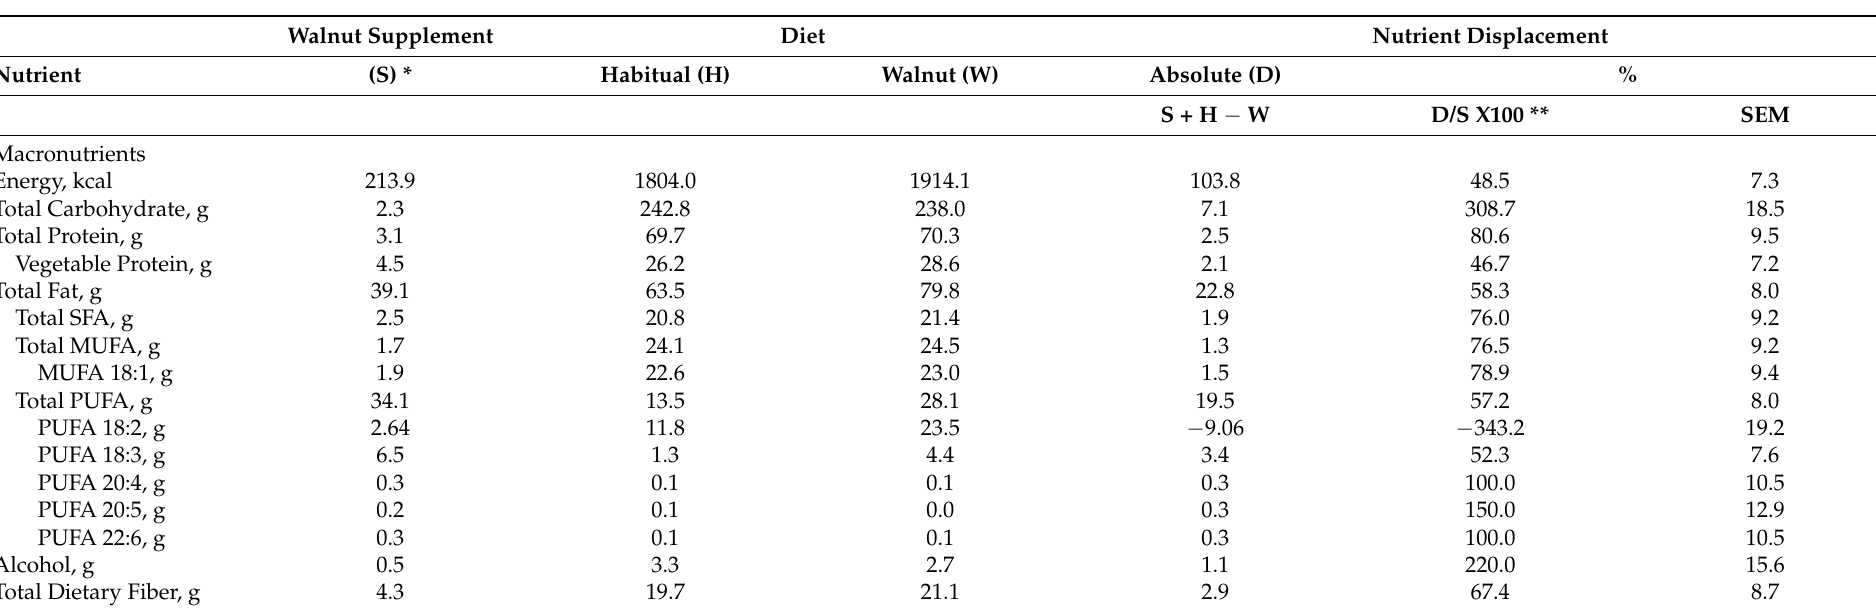
Table 5. Displacement of specific macronutrients after 6 months of walnut supplementation. All values are means of reported intake on 7 24-h